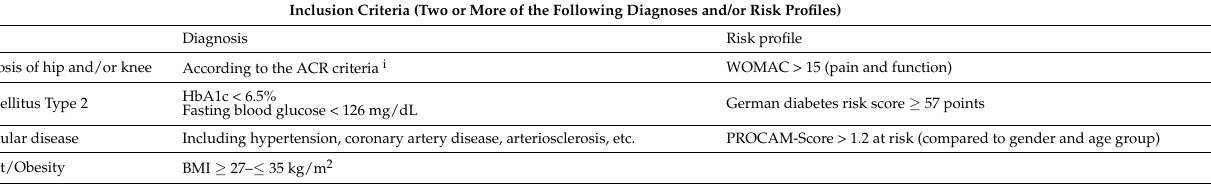
Table 1. Eligibility criteria for study participation displaying the inclusion and exclusion